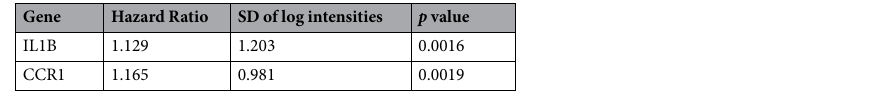
Table 3. Survival analysis of miR-181d-targeted genes. SD of log intensities: standard deviation of the log 2 of the gene expression